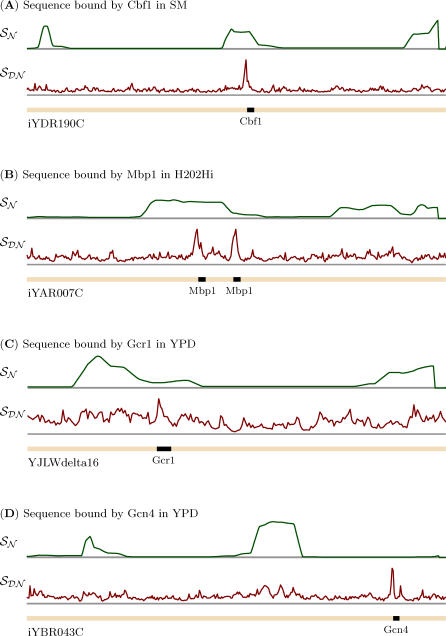
Nucleosome Occupancy and the Values of S℘D℘
N℘ over Four Intergenic Sequences(A) iYDR190C in Cbf1_SM, (B) iYAR007C in Mbp1_H2O2Hi, (C) YJLWdelta16 in Gcr1_YPD, and (D) iYBR043C in Gcn4_YPD. The boxes indicate binding sites annotated by Harbison et al. [2]. S℘D℘
N℘ at the locations of each of these binding sites has a high value relative to the rest of the sequence regardless of the S℘N℘ score at those sites. In particular, in spite of the low accessibility at the binding sites of Gcr1 (in YJLWdelta16) and Gcn4 (in iYBR043C), S℘D℘
N℘ correctly indicates a high prior probability at those regions.